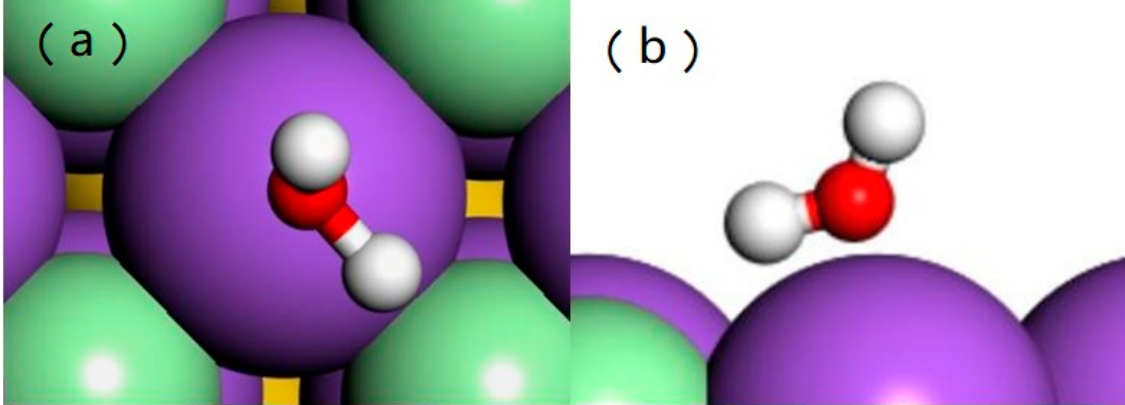
Figure 4. Refined structure of the water monomer on the NaCl(001) bilayer surface, based on Au(111) substrate. Image ( a ) is the top view and ( b ) is the side